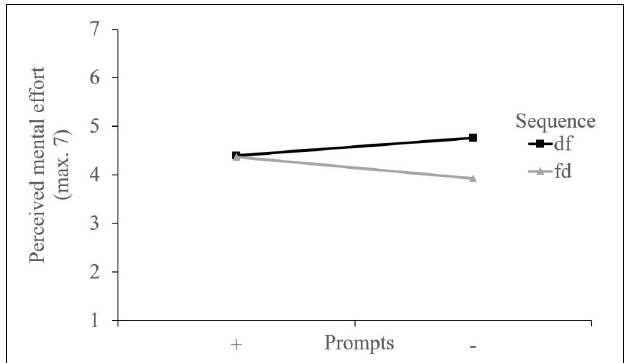
FIGURE 5 | Interaction plot regarding perceived mental effort.